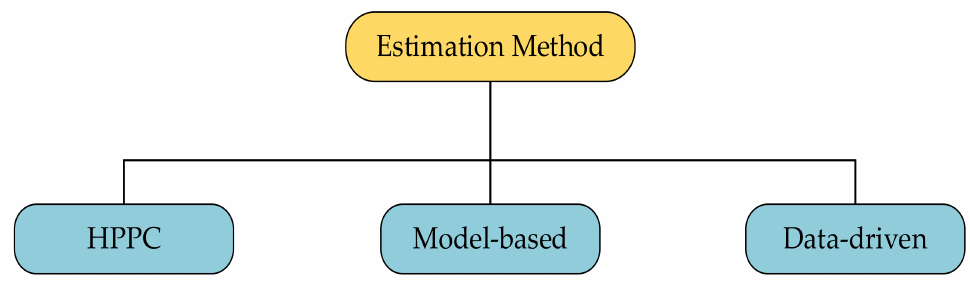
Figure 8. SOP-estimation methods